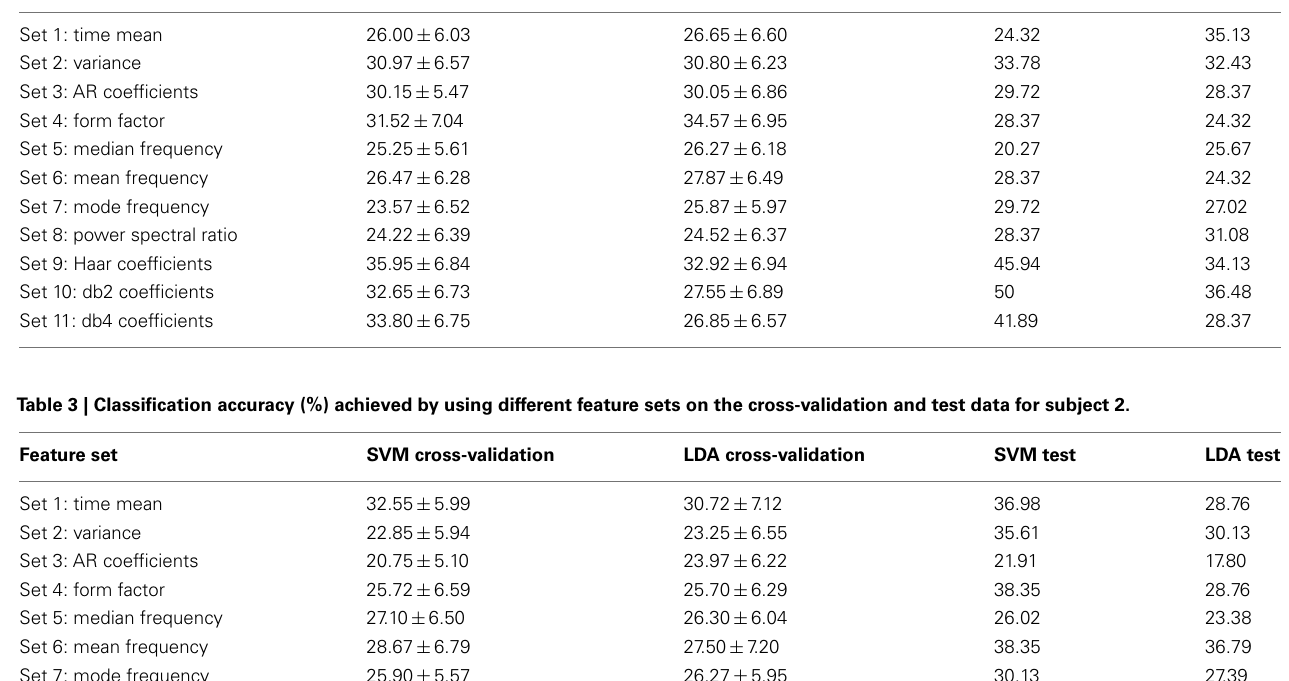
Table 2 | Classification accuracy (%) achieved by using different feature sets on the cross-validation and test data for subject 1. Feature set